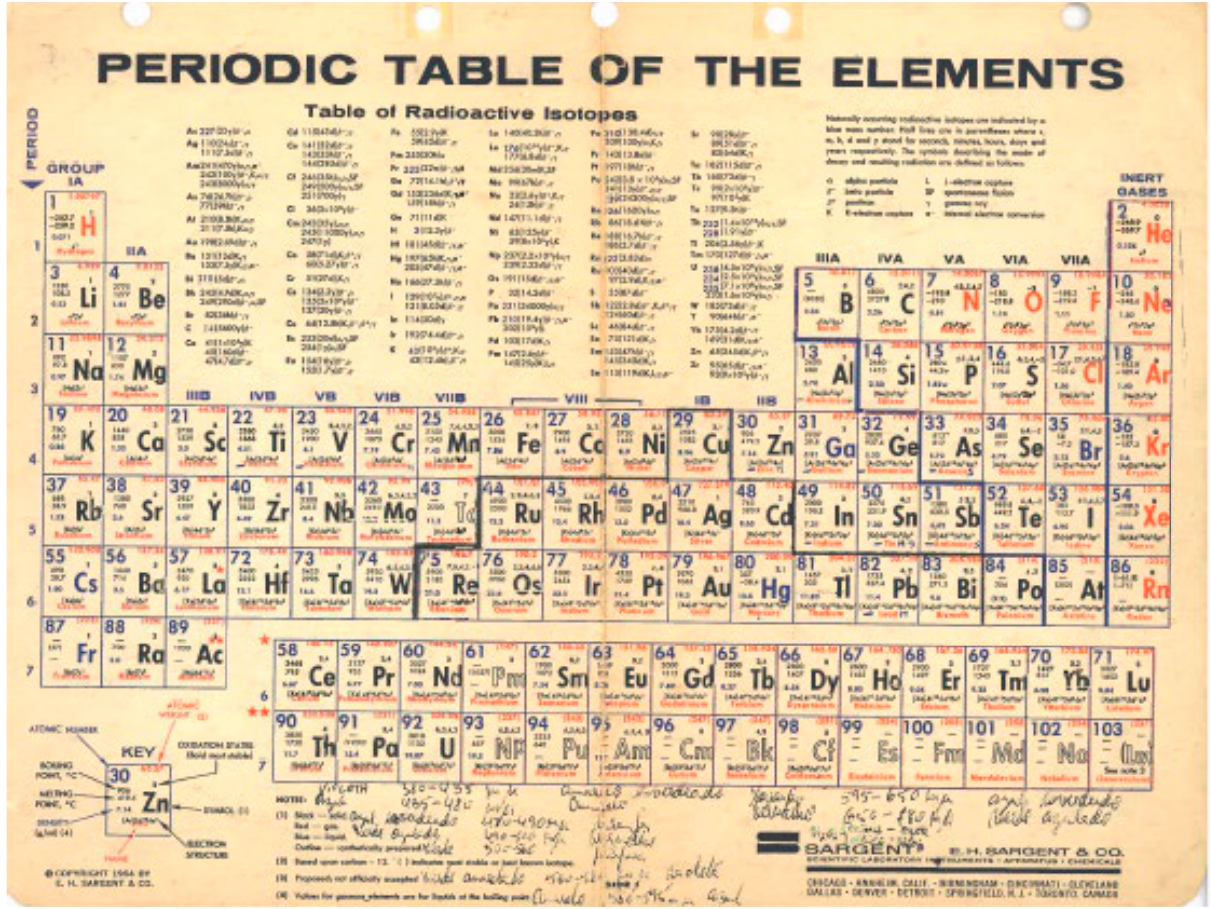
Figure 7. Periodic classification chart by E. H. Sargent & Co. Photo by João